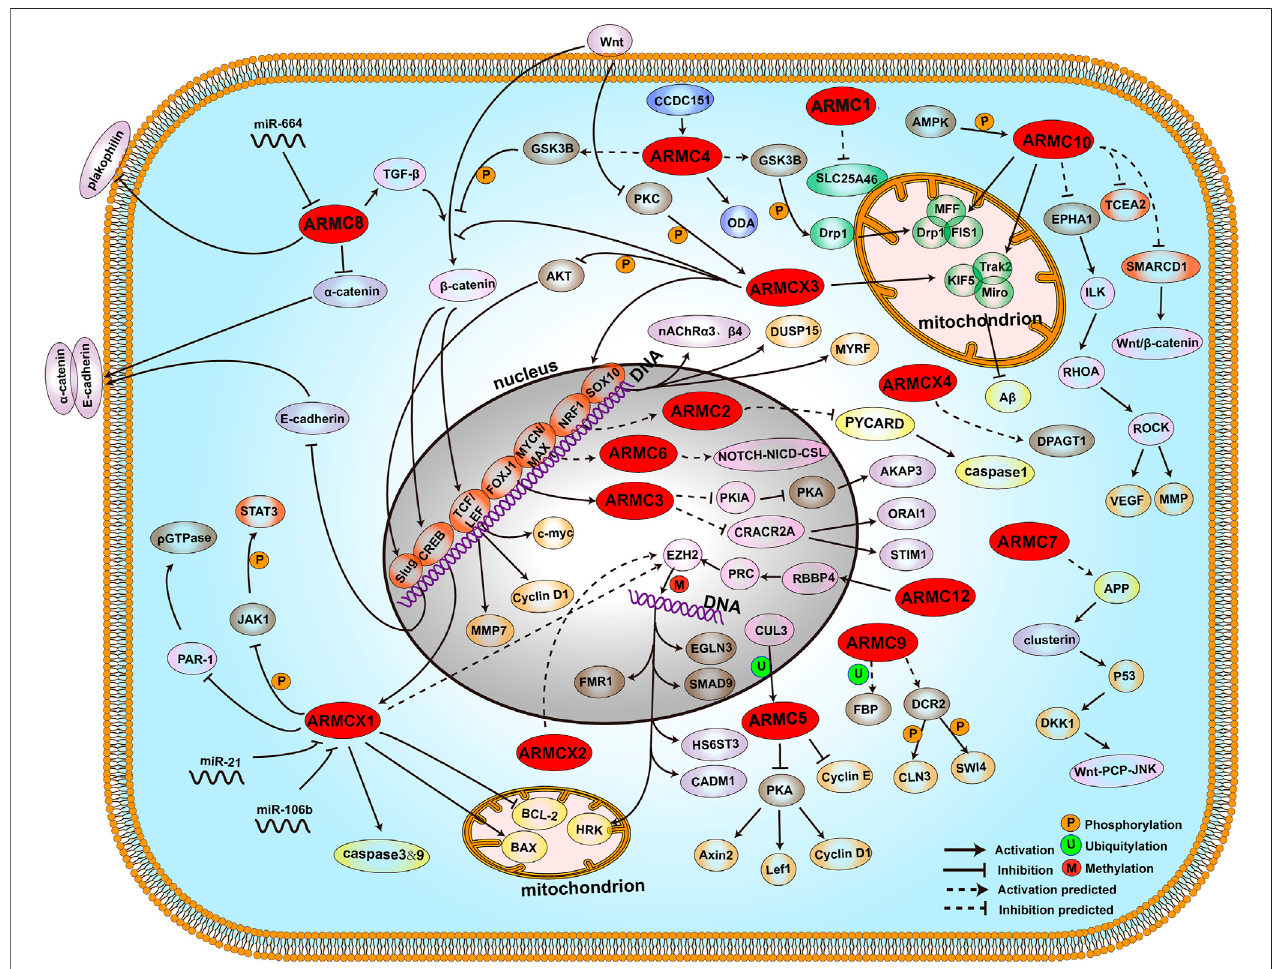
FIGURE 4 | ARMCs and pathways. The locations of proteins and compounds are roughly depicted. Shown are the ARMC subfamily (red), transcription factors (orange), mitochondrial-related proteins (green), proliferation and cell cycle-related proteins (wheat), apoptosis-related proteins (yellow), modi fi cation-related proteins (sand), ODA-related proteins (blue), cadherin-related proteins (purple), and other proteins (pink). The phosphorylation modi fi cation, ubiquitylation modi fi cation, and methylation modi fi cation are shown as orange circles (P), green circles (U), and red circles (M), respectively.